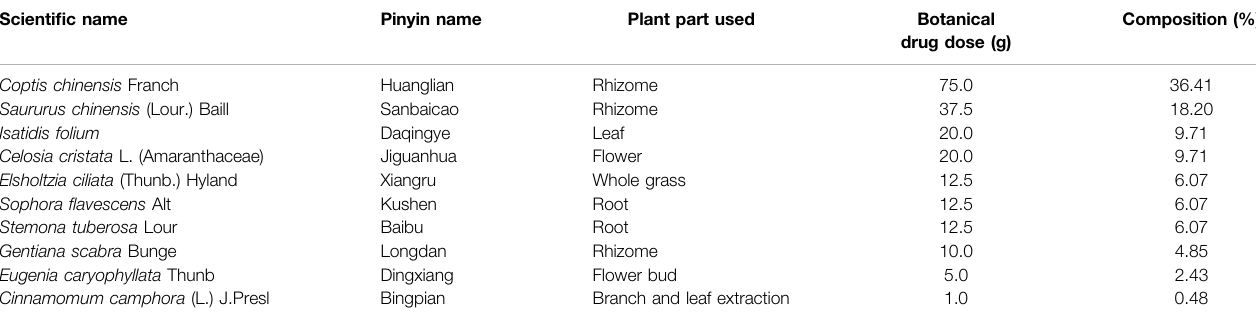
TABLE 1 | The botanical composition of KBN.